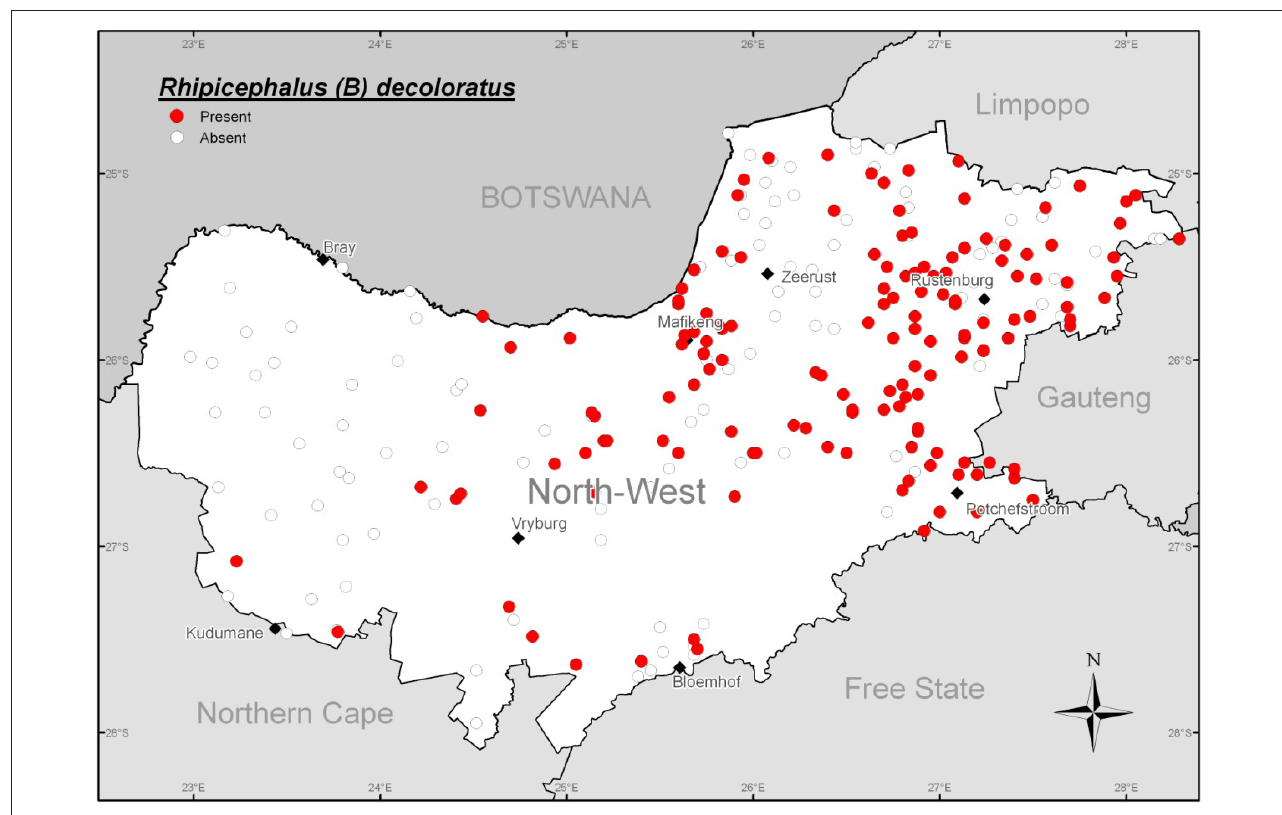
FIGURE 7: The geographic distribution of Rhipicephalus ( Boophilus ) decoloratus in the North West province, South Africa.